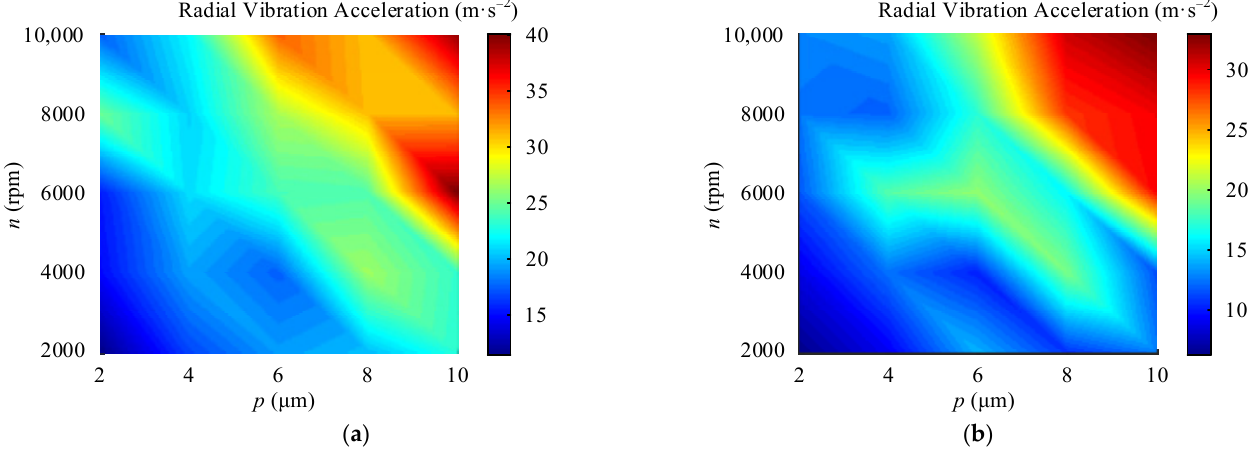
Figure 13. Variation law of radial vibration acceleration of the DGB 6205 system with speed n and radial clearance p : ( a ) X -direction radial vibration acceleration and ( b ) Y -direction radial vibration acceleration.